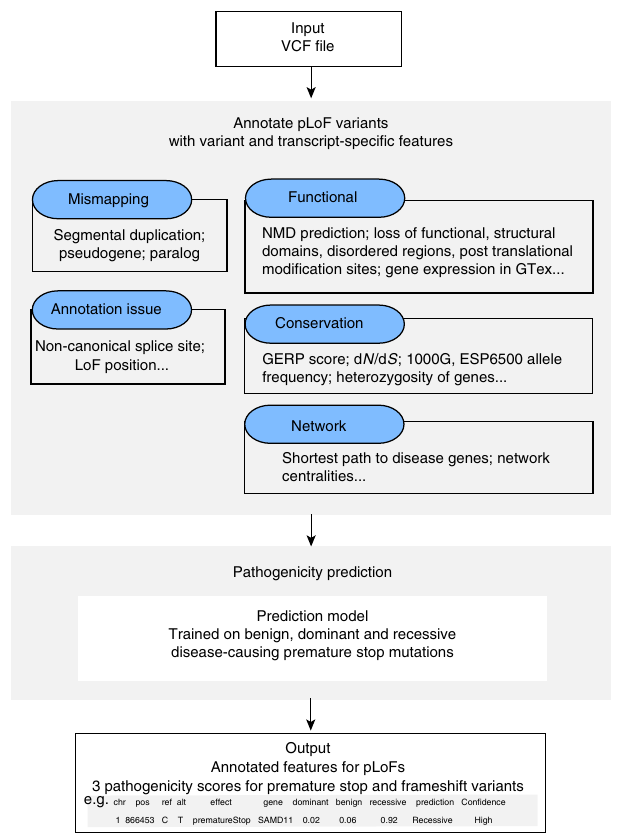
Fig. 1 Schematic work fl ow. ALoFT uses a VCF fi le as input and annotates premature stop, frameshift-causing indel and canonical splice-site mutations with functional, conservation, and network features. ALoFT also fl ags potential mismapping and annotation errors. Using the annotation features, ALoFT predicts the pathogenicity (as either benign, recessive, or dominant disease-causing) of premature stop and frameshift mutations based on a model trained on known data. ALoFT can also take as input a fi ve-column tab-delimited fi le containing chromosome, position, variant ID, reference allele, and alternate allele as its